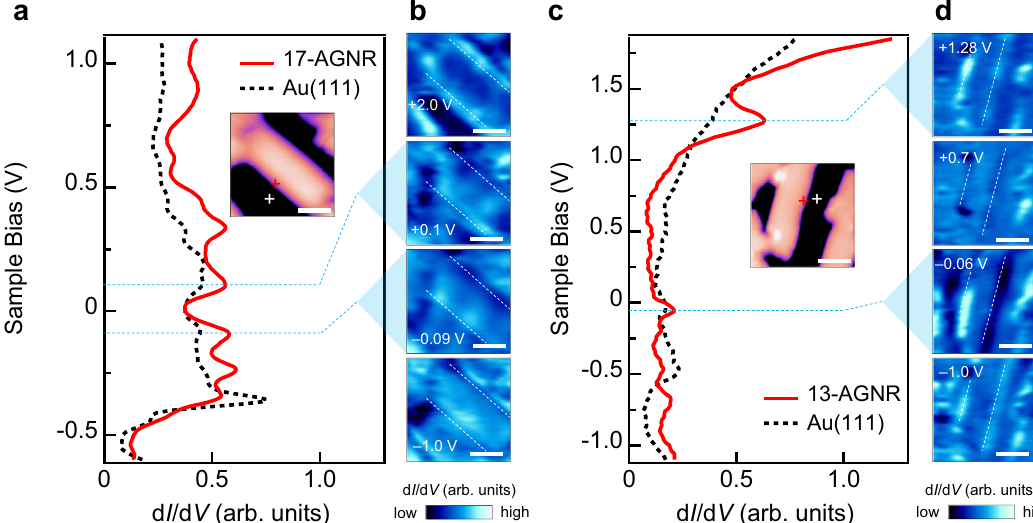
Fig. 5 Electronic state characterization of 17- and 13-AGNRs. a Differential conductance (d I /d V ) point spectra recorded on edge of single 17-AGNR (red line) and Au(111) surface (black dotted line). Crosses in inset of STM image indicate tip positions for STS. Open-feedback setpoints were V s = − 1.1 V, I t = 0.41 nA. b Constant-height d I /d V maps ( I t = 0.41 nA) of the 17-AGNR obtained at energies indicated in each map. Dashed lines indicate outer edges of the AGNR. c d I /d V spectra of single 13-AGNR on Au(111) recorded at tip positions marked with crosses in inset STM image (setpoints: V s = 2.2 V, I t = 0.8 nA). d d I /d V maps ( I t = 0.8 nA) of the 13-AGNR obtained at respective energies shown in each map. All STS data were obtained at 5 K. All scale bars, 2